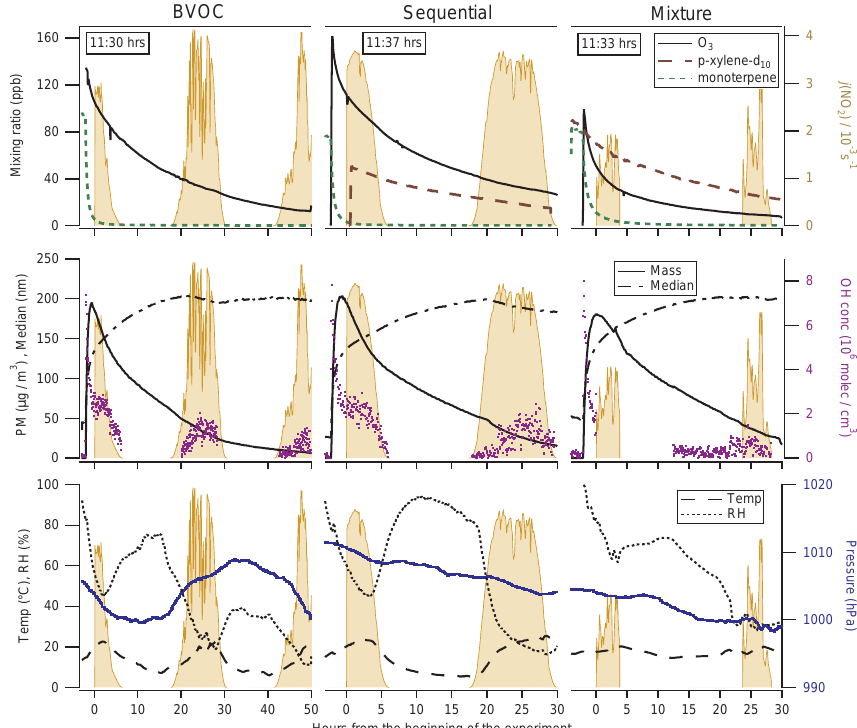
Figure 2. Time series of the three experiments performed. The BVOC, sequential, and mixture experiments are shown in the left, middle, and right column, respectively. The mixing ratio of ozone (black line), the mixture of α -pinene and limonene (monoterpenes, dotted green line), and p -xylene-d 10 (red dashed line) are shown in the top panels. The total mass (black line), median diameter (black dash-dot line), and OH concentration (purple dots) are shown in the middle panels. The temperature (black dash line), relative humidity (black dotted line), and pressure (blue dots) are shown in the lower panels. The photolysis rates of NO 2 (orange area) are presented in all panels to indicate the diurnal cycles; the rate values are shown on the top-right axis. NO x levels were below 1ppbv and are not shown here. The local time at which each experiment began is shown in the top